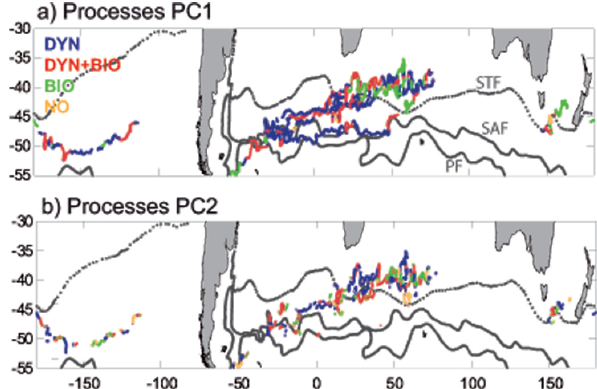
Fig. 6. Dominant processes influencing the variability at small spa- tial scales identified using (a) the first principal component (PC1), (b) the second principal component (PC2) loadings obtained with the local PCA for DIC, SST and fluorescence. Processes are ocean dynamical advection (DYN), biological uptake of DIC (BIO). NO indicates when none of these processes could be